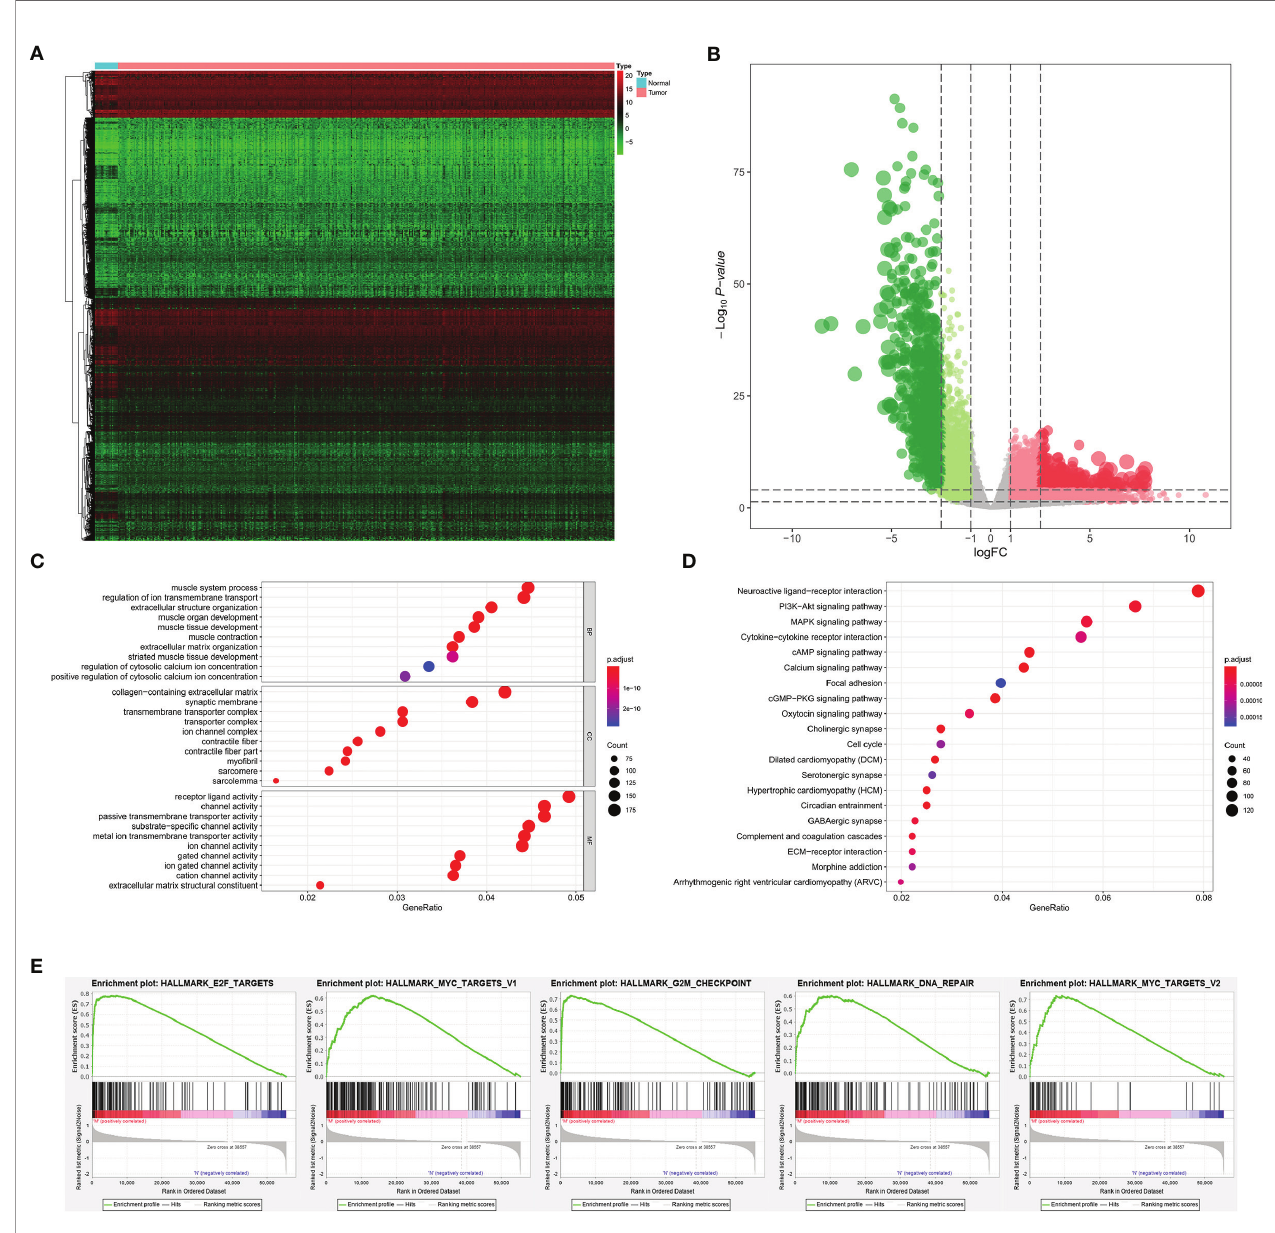
FIGURE 2 | The results of differential expression genes analysis and functional enrichment analysis between primary BLCAs and normal solid tissue samples: The heatmap (A) and volcano plot (B) of the differential expressed genes. The GO (C) , KEGG (D) , and (E) top fi ve GSEA enriched terms for the differential expressed